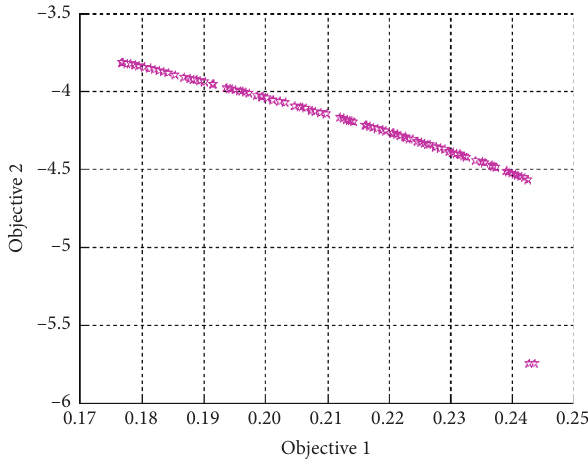
Figure 12: Pareto optimal